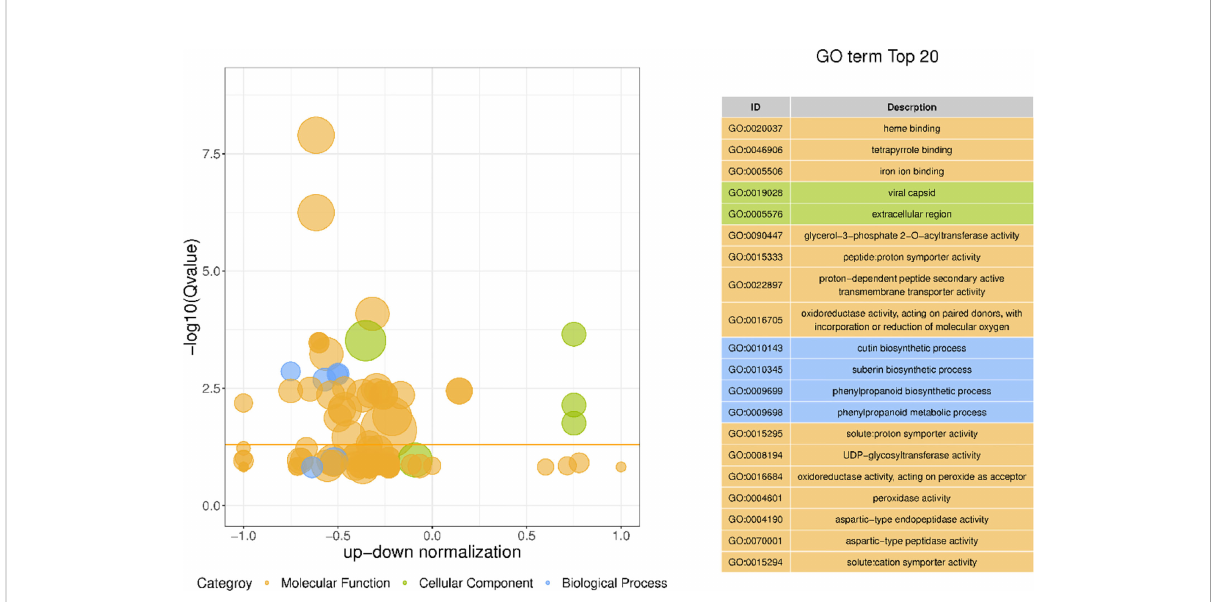
FIGURE 7 The bubble plot GO enrichment difference and top 20 items of GO enrichment of differentially expressed genes The ordinate is -log10 (Q value), the abscissa is the z-score value (the ratio of the difference between the number of up-regulated differential genes and the number of down-regulated differential genes to the total differential genes); the yellow line represents the threshold of Q value=0.05; On the right is a list of the top 20 GO terms with a Q value; different bubble colors and GO term colors in the fi gure represent different ontologies.